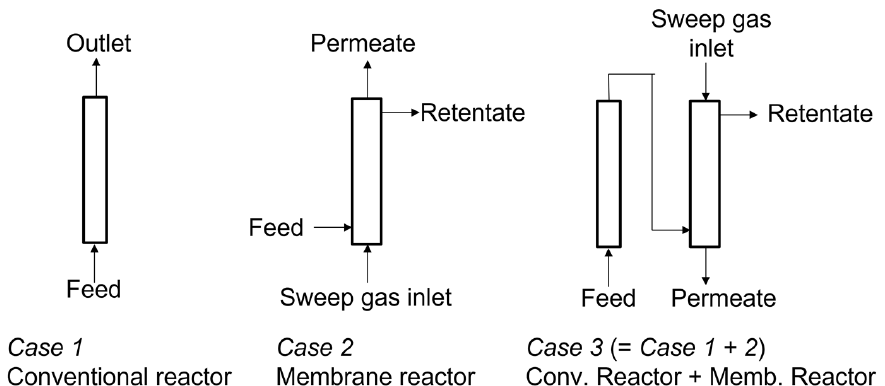
Figure 1. Configurations of RWGS reactors. Case 1 , conventional plug-flow reactor; Case 2 , membrane reactor; Case 3 , combination of conventional and membrane reactors.